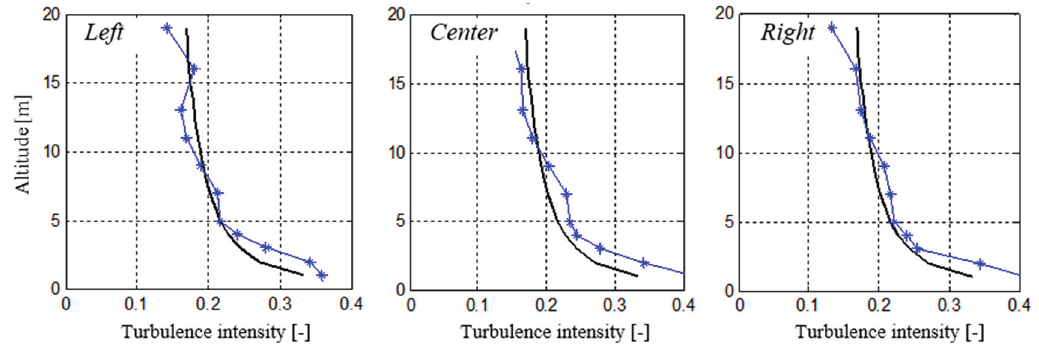
Figure 7. Vertical profile of mean wind speed. Blue stared: LES results. Black line: Eurocode.